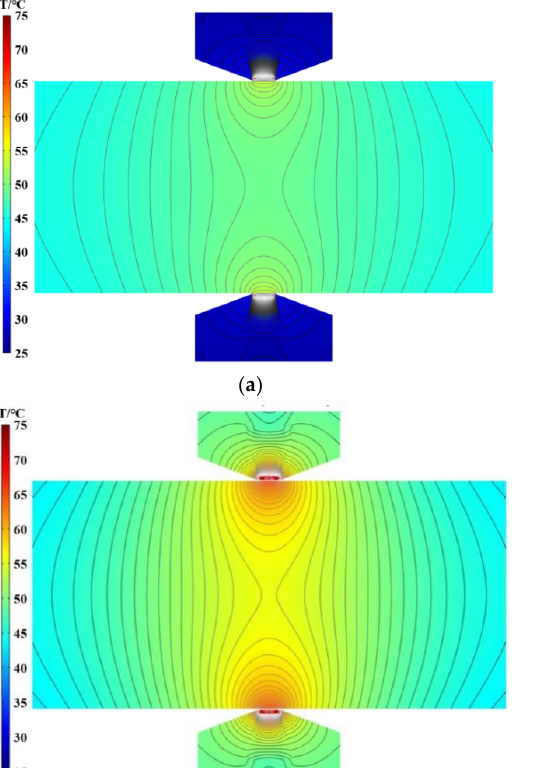
( d ) Figure 8. Temperature cloud of the MR fluid seal at different speeds with H = 0: ( a ) 300 rpm; ( b ) 600 rpm; ( c ) 900 rpm; and ( d ) 1500 rpm.